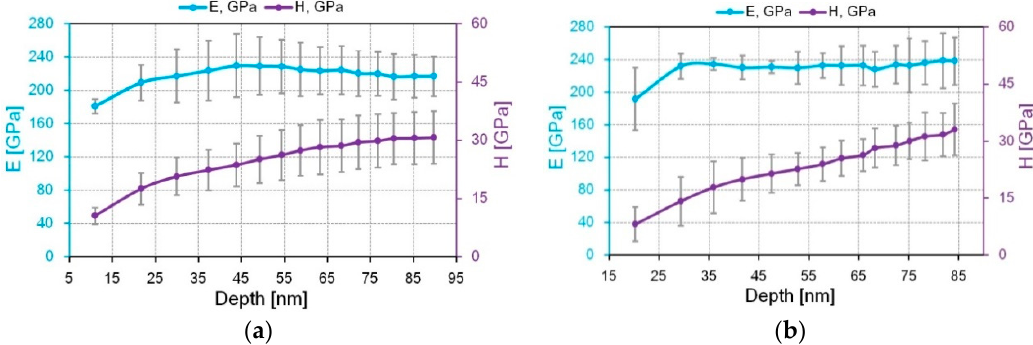
Figure 15. The dependences of E and H from the indentation depth in CrN ( a ) and Al 50 Cr 50 N coatings ( b ).